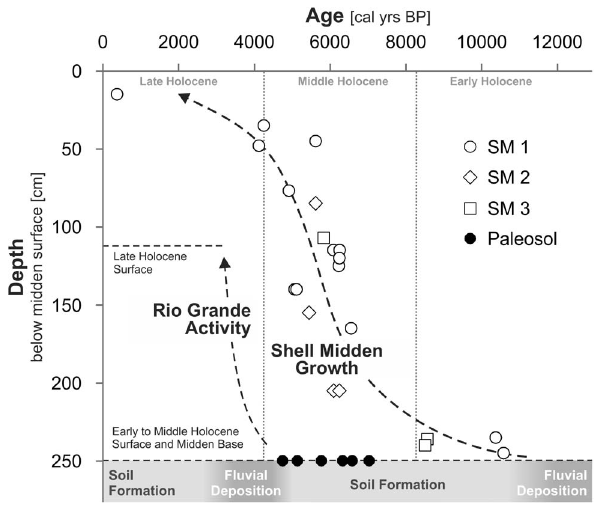
Figure 9. Relation between age and depth of the radiocarbon dated samples. Depth for the paleosol samples is in relation to the surface of SM1. Subdivision of the Holocene in early, mid and late is based on